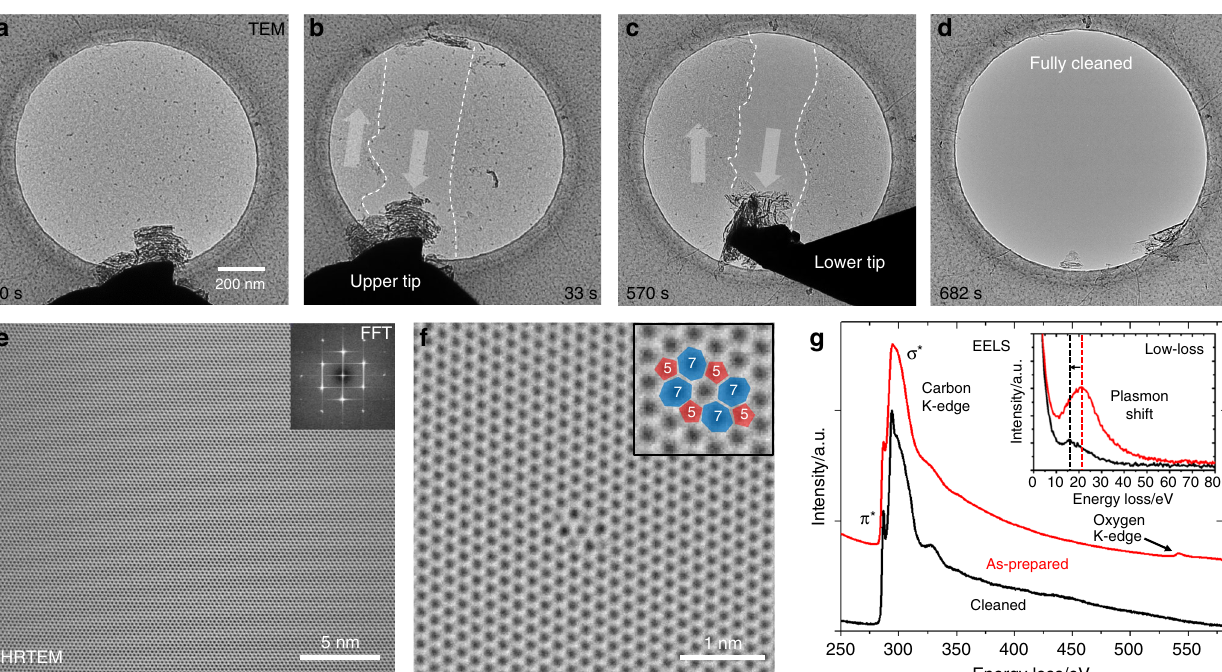
Fig. 3 In situ mechanical cleaning approach in the TEM. a TEM image of a graphene membrane with residual contamination. b , c Consecutive cleaning from both sides results in an atomically clean membrane ( d ). HRTEM ( e ) con fi rms the level of cleanliness and pristine state of the graphene. The FFT (inset) con fi rms to the graphene structure. Only intrinsic defects such as divacancies ( f ) are found on the membrane with no additional defects being introduced by the cleaning method. g EELS spectra of as-prepared and (SEM) cleaned graphene membranes. The oxygen signal from the PMMA residuals disappears after cleaning. Moreover, the plasmon loss peak decreases in intensity and shifts to lower